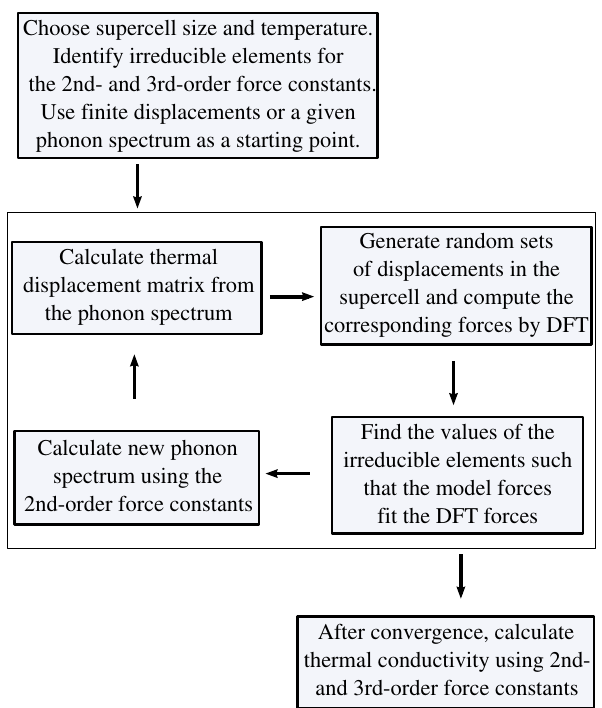
FIG. 1. Workflow of the method used to calculate the phonon spectrum and thermal conductivity including finite-temperature anharmonic